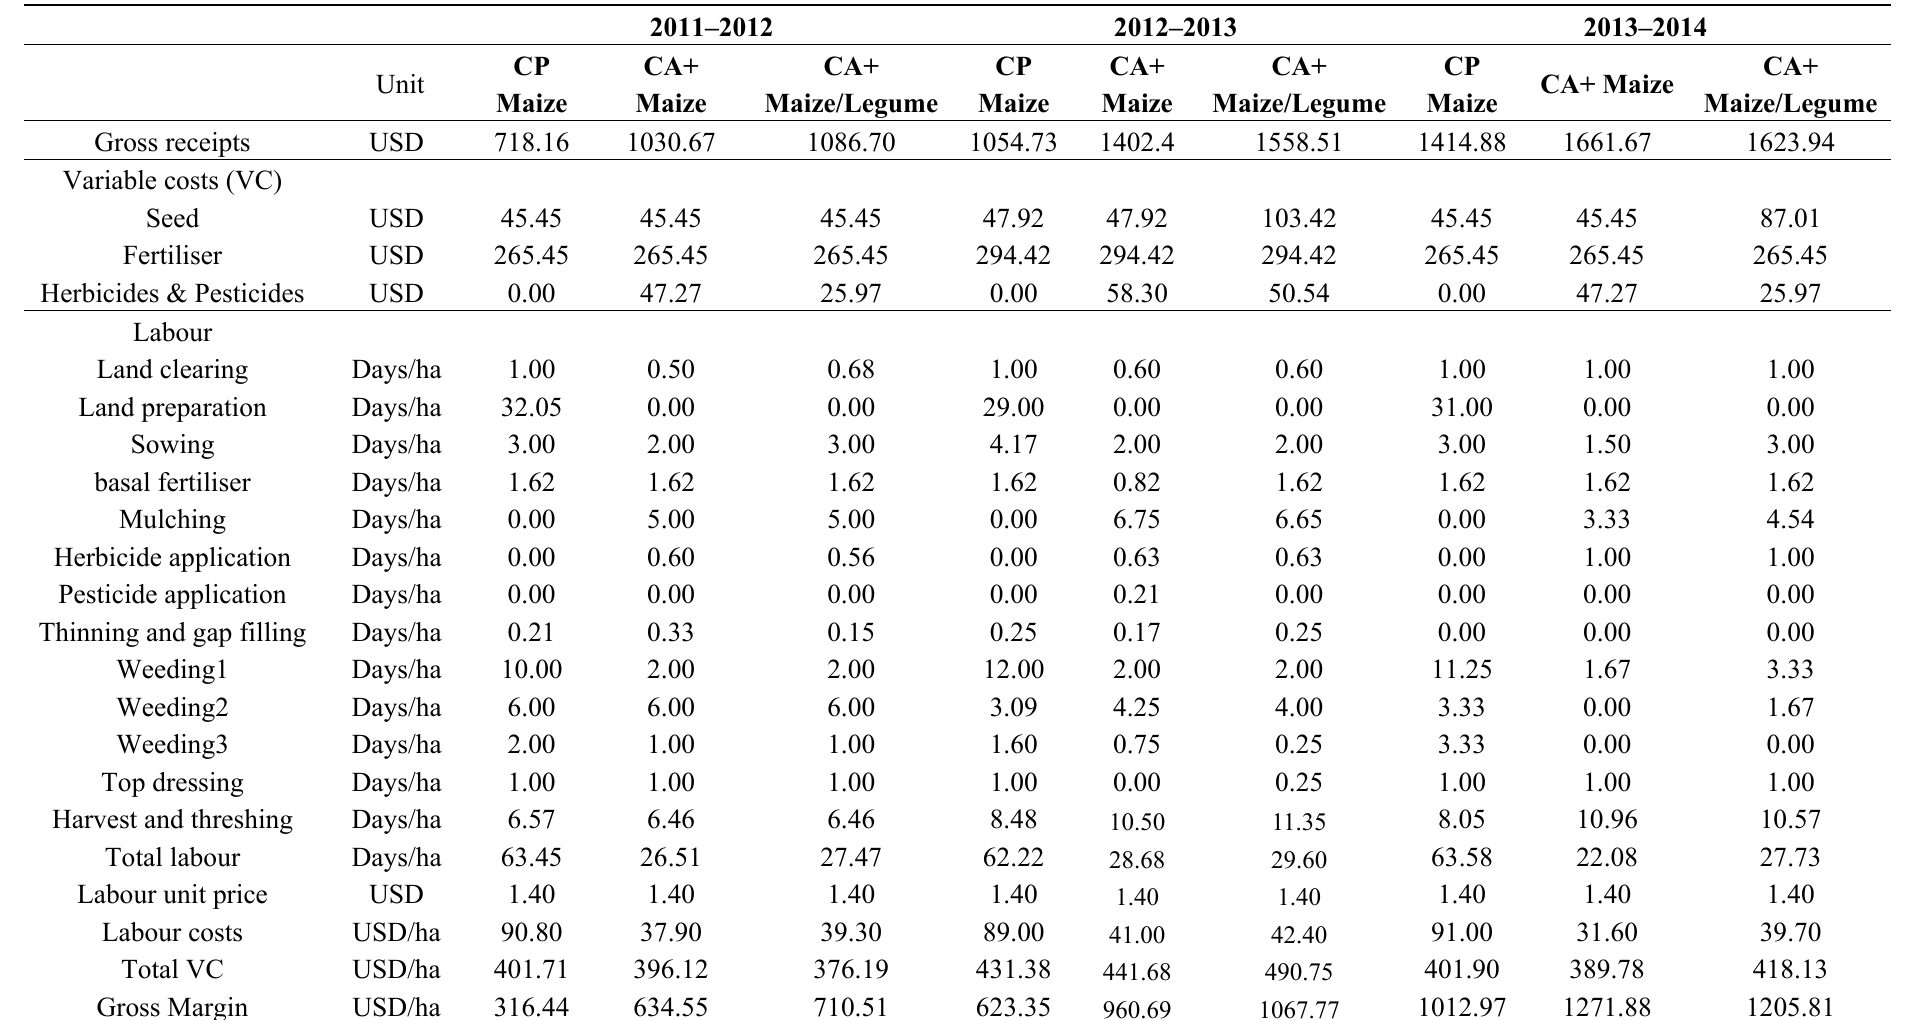
Table 5. Gross margin analysis (in US$·ha −1 ) of different cropping systems practiced under on-farm trials at Zidyana, Malawi,